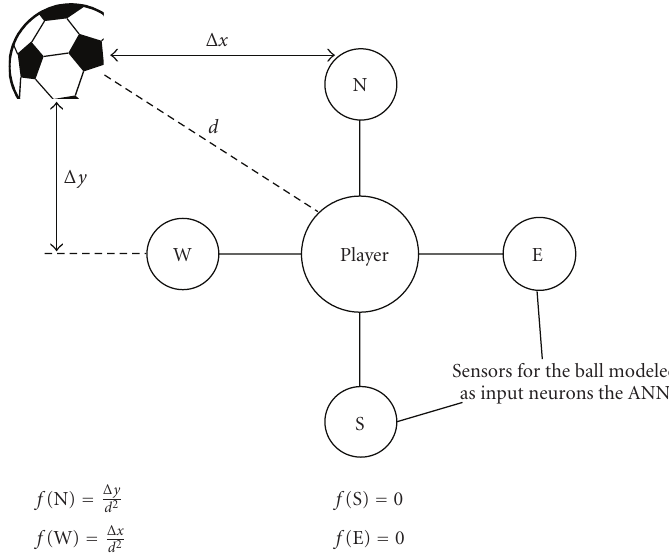
Sensors for the ball modeled as input neurons the